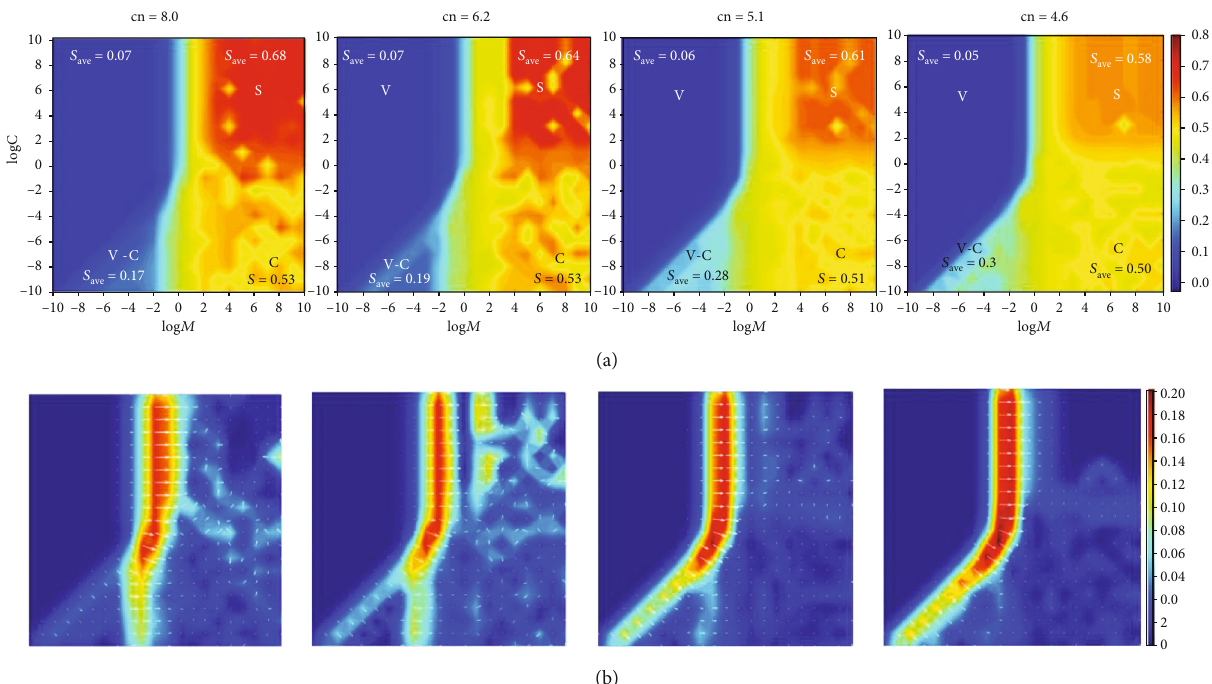
Figure 7: E ff ect of the coordination number on the displacement e ffi ciency for the tube network model with a given tube size distribution ( σ = σ ). (a) Saturation of the invading fl uid. The coordination number is reduced from cn = 8 : 0 to cn = 4 : 6 by removing randomly chosen 0 tubes from the original tube network model. (b) Gradient in the displacement e ffi ciency